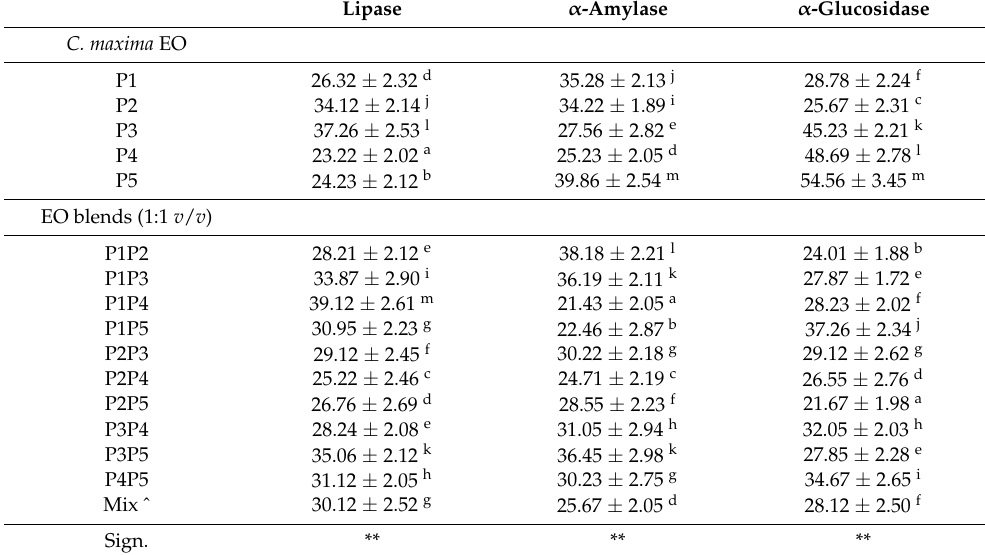
ˆ Blend obtained by combination P1, P2, P3, P4, and P5 EOs (1:1 v / v ). Data are expressed as means ± standard devi- ation (SD). The following positive controls were used: Acarbose for α -amylase (IC 50 value of 35.53 ± 1.28 µ g/mL) and α -glucosidase (IC 50 value of 50.09 ± 1.34 µ g/mL); Orlistat for lipase (IC 50 value of 37.42 ± 1.08 µ g/mL). Sign: significance at ** p < 0.05. Results followed by different letters in the same line are significantly different according to Tukey’s multiple-range